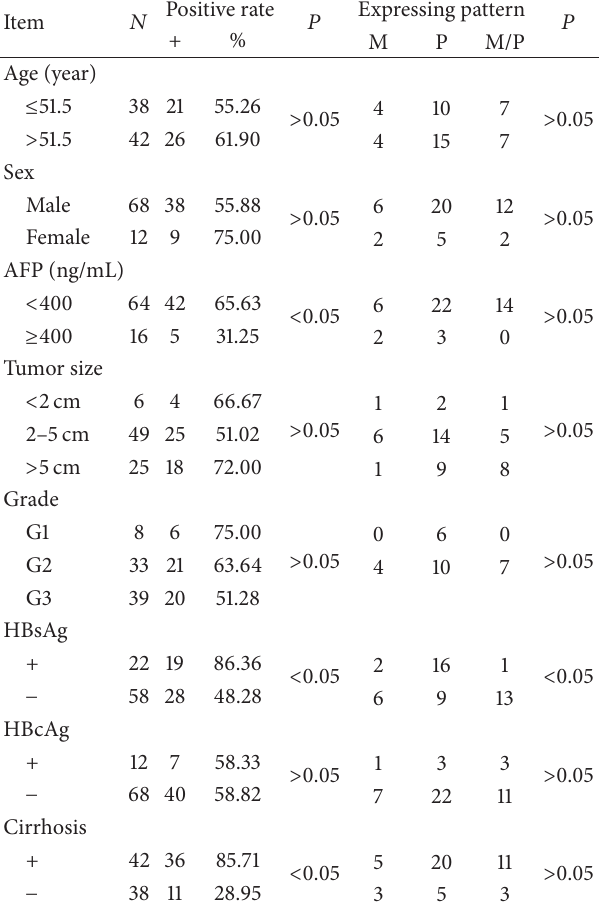
Table 3: Correlation between TLR3 expression and clinicopatho- logic characteristics in HCC.